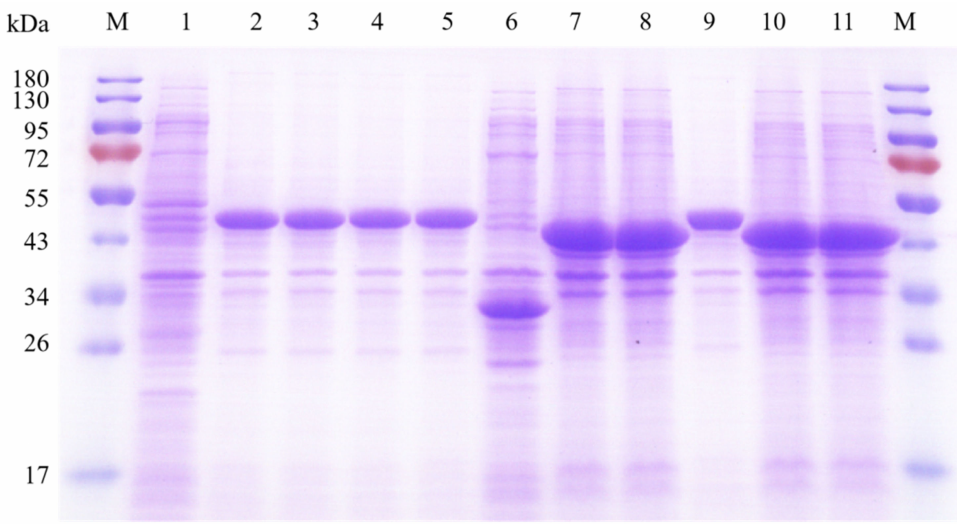
Figure 1. SDS-PAGE analysis of ten old yellow enzymes. Lane M, marker; Lane 1, no induction of old yellow enzyme as the control; lane 2, OYE3 (45 kDa); lane 3, OYE2p (45 kDa); lane 4, OYE2y (45 kDa); lane 5, OYE2y-HG (45 kDA); lane 6, NemR-SG (33 kDa); lane 7, NemR-CK (39 kDa); lane 8, NemR-CR (39 kDa); lane 9, NemR-CT (44 kDa); lane 10, NemR-CS (39 kDa); lane 11, NemR-PS (39 kDa). The percentage of acrylamide in the resolving gel was 12%. The value in the bracket represents the apparent molecular mass of old yellow enzymes. Table 1. Comparison of activity and enantioselectivity of ten old yellow enzymes in cell-free extracts. Old Yellow Enzyme GenBank Accession